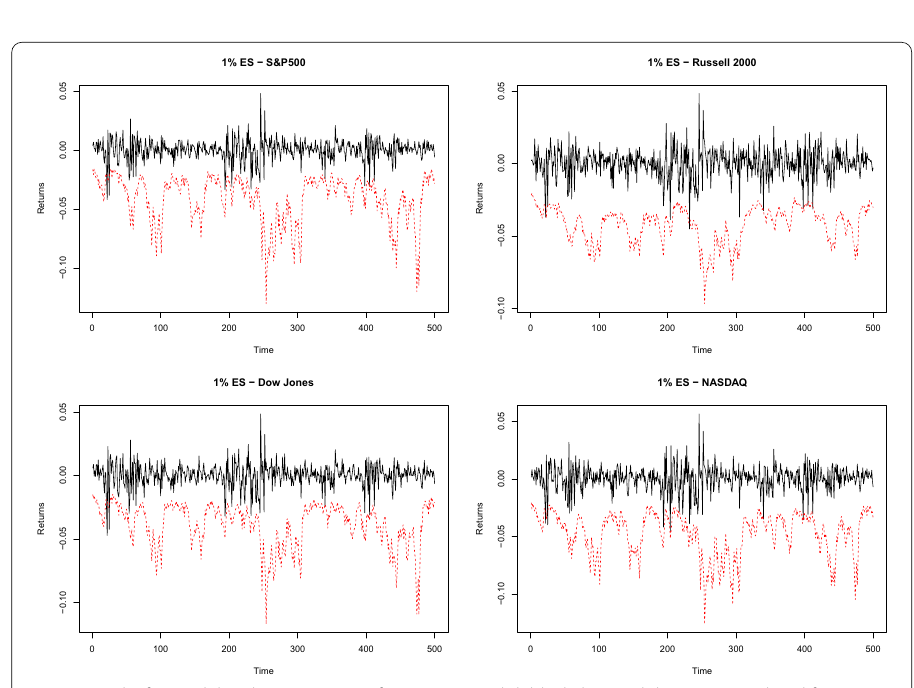
Fig. 6 Results for Model 4. The time series of returns is in solid (black) line and the one-step ahead forecasts ES are in dashed (red) of −